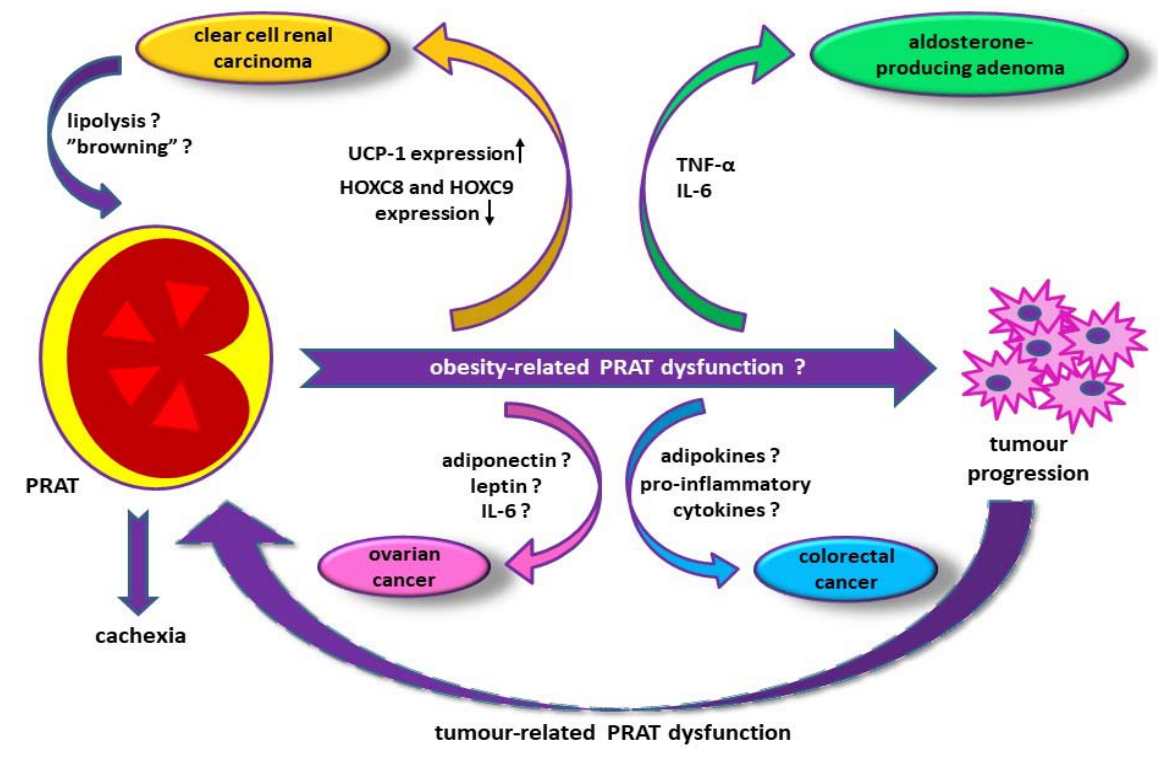
Figure 2. Hypothetical pathways of perirenal adipose tissue (PRAT) induced tumor progression. HOXC8—homeobox protein 8; HOXC9—homeobox protein 9; IL-6—interleukin 6; PRAT—perirenal adipose tissue; TNF- α —tumor necrosis factor- α ; UCP-1—uncoupling protein 1; ↑ —increased level; ↓ —decreased level; ?—unknown .